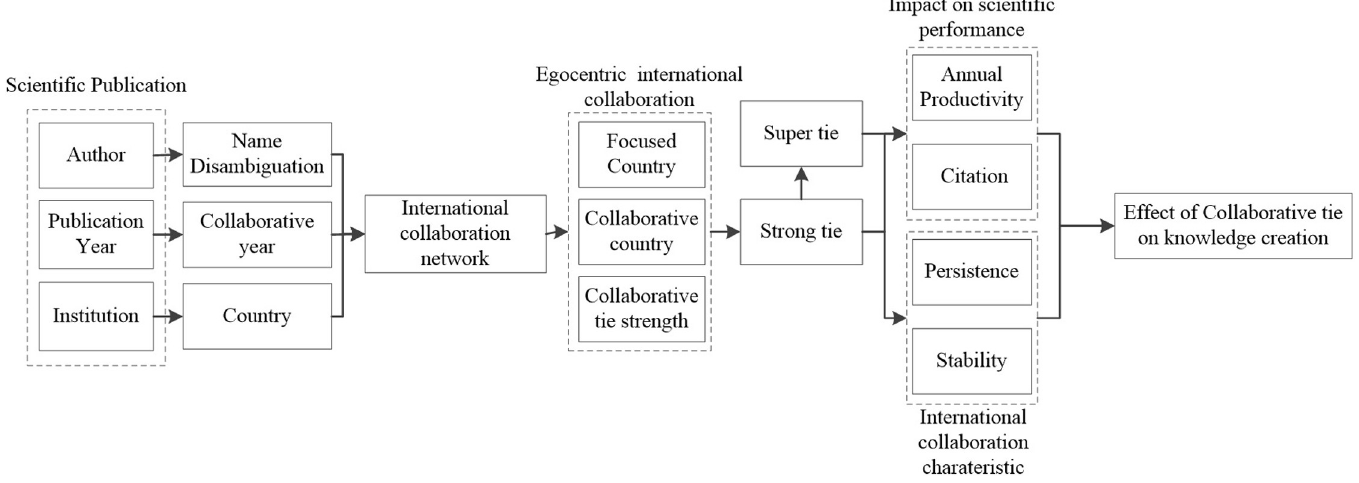
Fig 3. Research framework of this